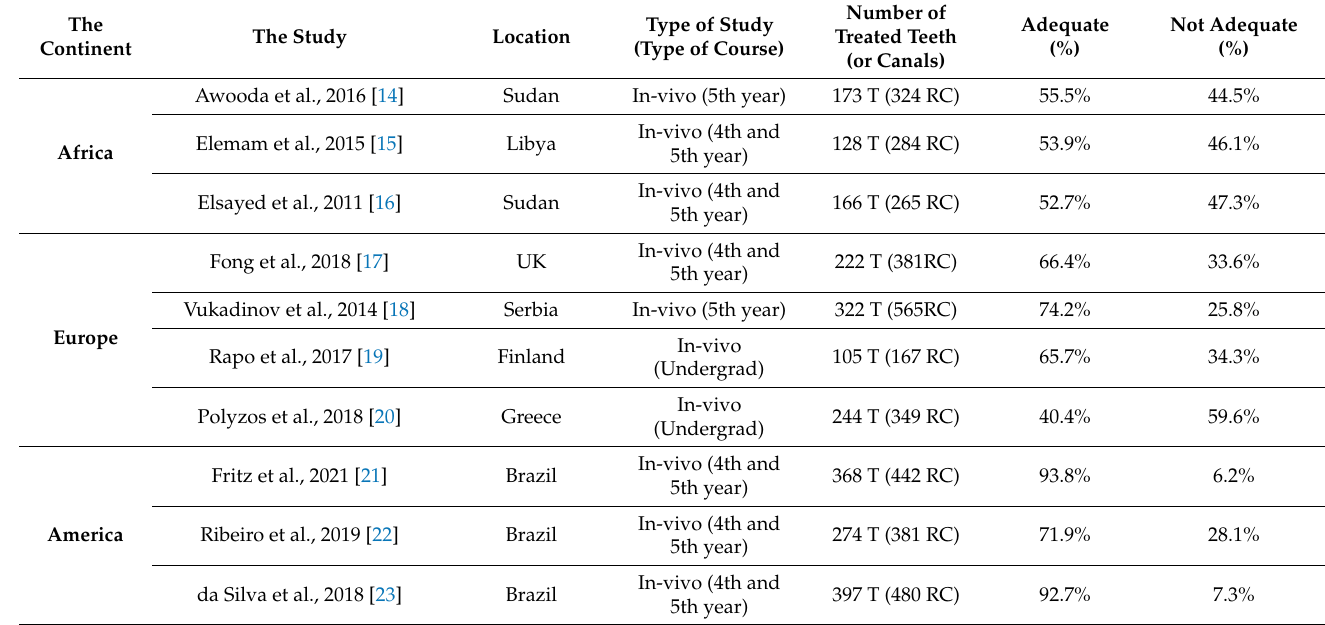
Table 1. Adequacy of root canal treatment conducted by dental students in the last 10